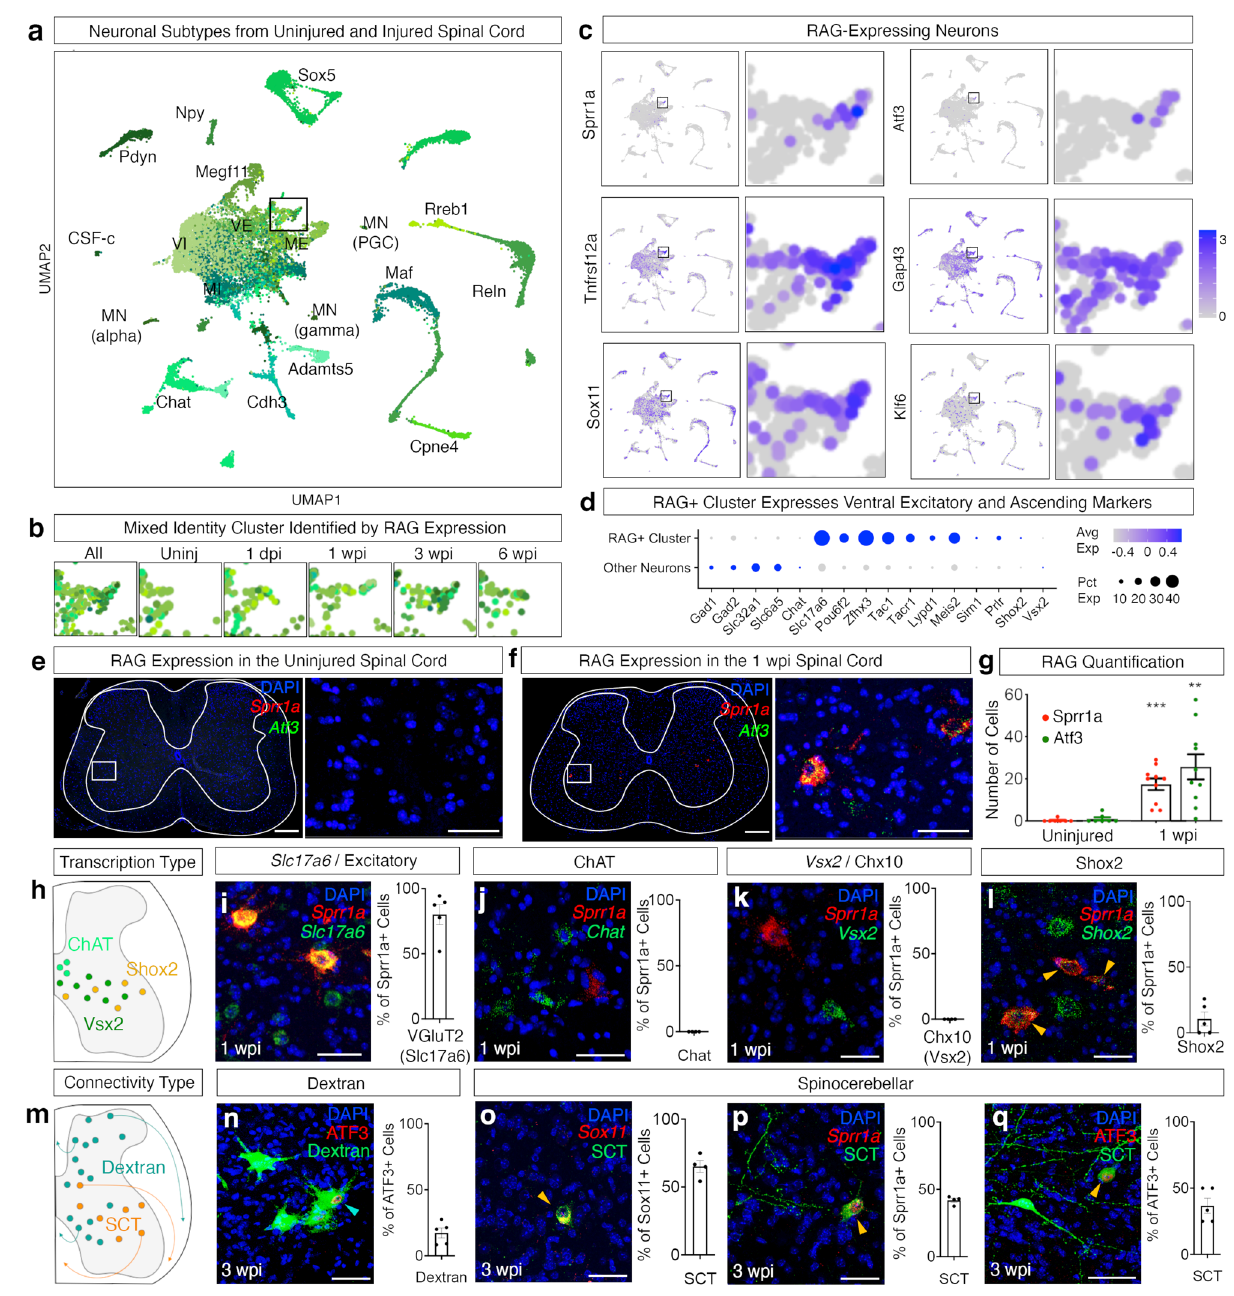
Fig. 4 | Speci fi c neurons express genes associated with regeneration. a UMAP showing predicted neuronal families. b Targeted view of RAG-expressing cluster over injury time points. c Featureplots showing RAGs expressed in neurons. d A dotplot showing expression of RAGs within targeted RAG-expressing cluster (clus- ter 23 de fi ned by independent clustering in Supplementary Fig. 5). Average expression(avgexp)isindicatedbycolor(graytoblue)andpercentexpressed (pct exp) is indicated by the size of the circle. e , f RNAscope in situ hybridization showing expression of Sprr1a and Atf3 in the uninjured cord and 1 wpi. Scale bars are 200 and 50 µ m, respectively. g Quanti fi cation of Sprr1a + cells and Atf3 + cells in the uninjured and 1 wpi injury cord ( p =0.001 shown as *** p =0.0037 shown as **, two-sided unpaired t-test, Error bars indicate ± SEM, N =7, 10). h Diagram of spatial locationoftranscriptiontypes,includingChAT(lightgreen),Vsx2(darkgreen),and Shox2 (orange). i – l Visualization and quanti fi cation of VGluT2/ Slc17a6 +, Shox2 +,